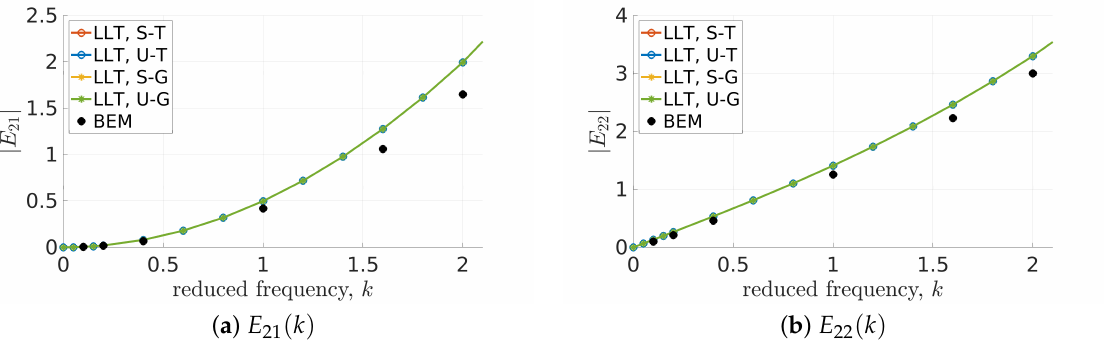
Figure 8. Transfer function E 12 ( k ) , NMV shape functions, l = 2.5m.